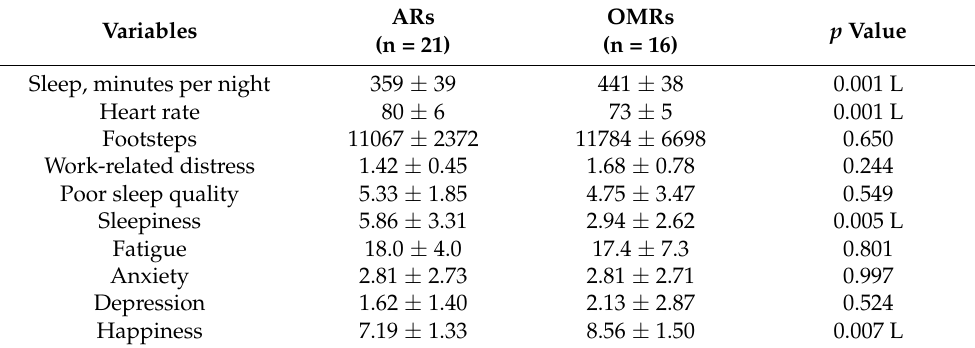
Table 1. Comparison of sleep and health-related variables between groups. For statistically significant correlations, the effect size was also